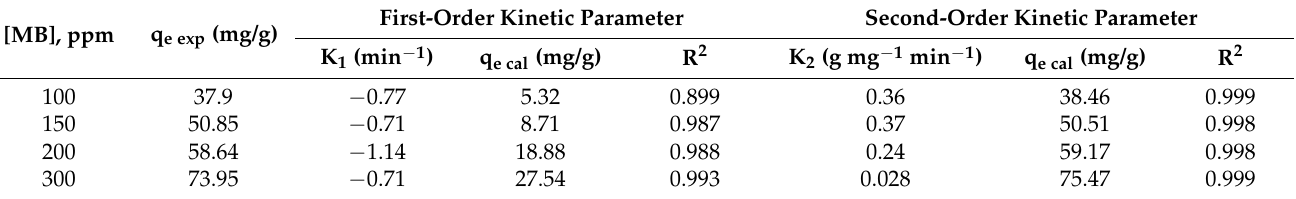
Table 2. The calculated parameters of the pseudo-first-order and pseudo-second-order kinetic model for various concentrations of MB